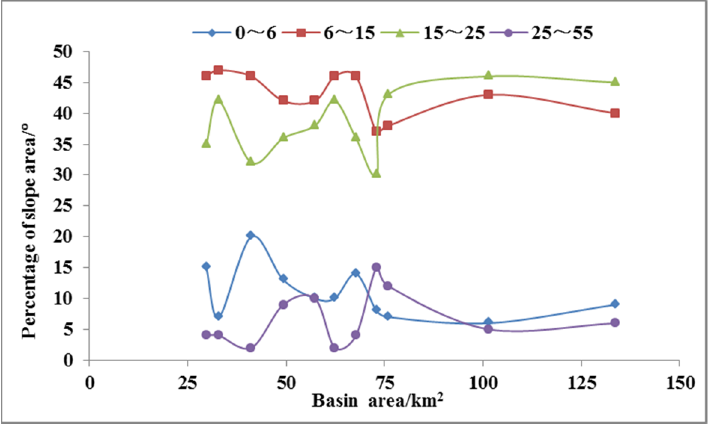
Figure 5. Percentage of area under different slopes varying with basin area.